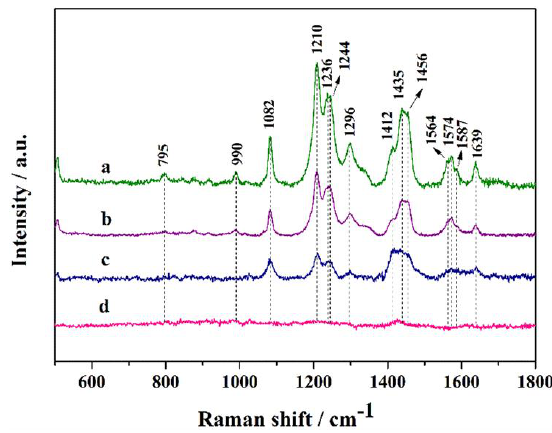
Figure 8. Raman spectra of DOX at different concentrations absorbed on Ag nanorod aggregates. Spectra represent the concentrations of DOX being ( a ) 5 ˆ 10 ´ 4 ; ( b ) 5 ˆ 10 ´ 5 ; ( c ) 5 ˆ 10 ´ 6 ; ( d ) 5 ˆ 10 ´ 7 M,